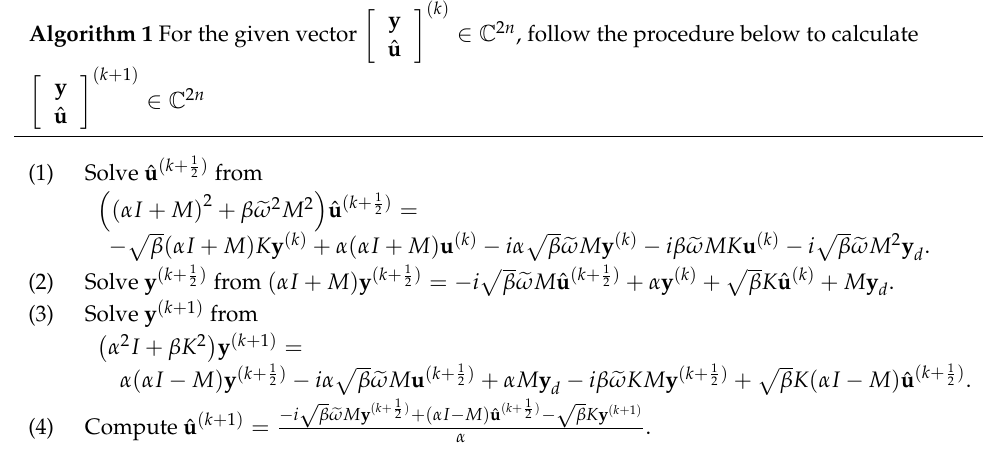
Algorithm 1 For the given vector